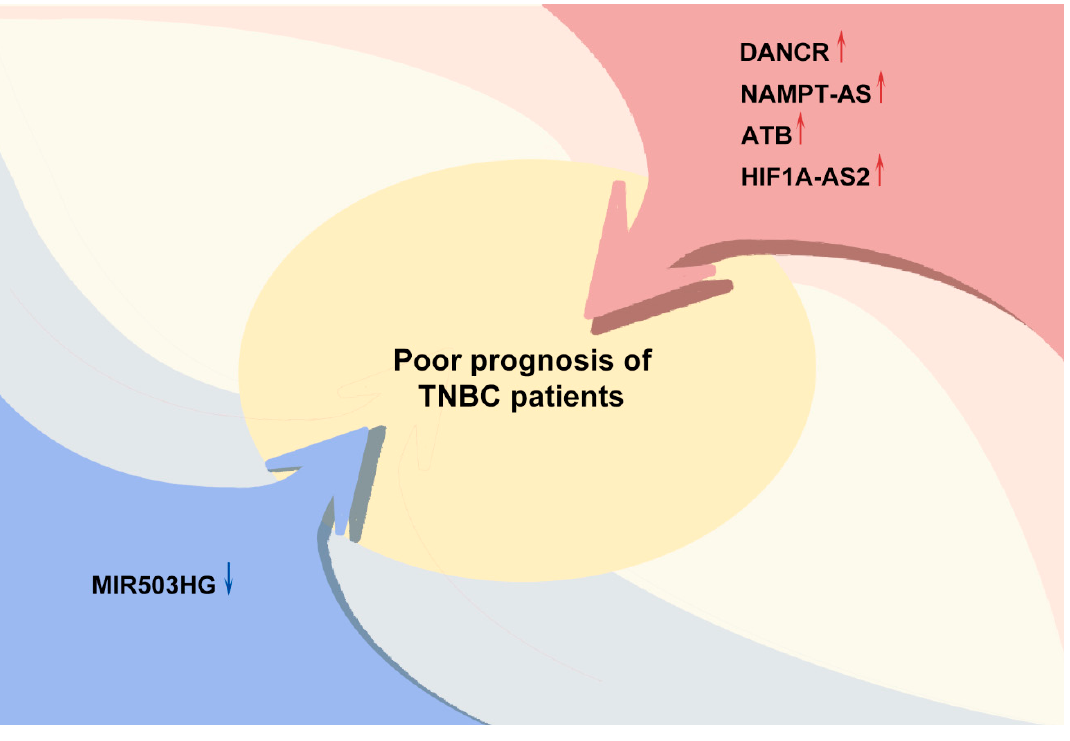
Figure 2. LncRNAs as biomarkers for diagnosis and prognosis of TNBC patients. Up-regulated expression of DANCR, NAMPT-AS, ATB, and HIF1A-AS2 predict poor prognosis of TNBC patients. Down-regulated expression of MIR503HG predicts poor prognosis of TNBC patients. Red up arrows refer to up-regulation of the relevant lncRNA. Blue down arrows refer to down-regulation of the relevant lncRNA.